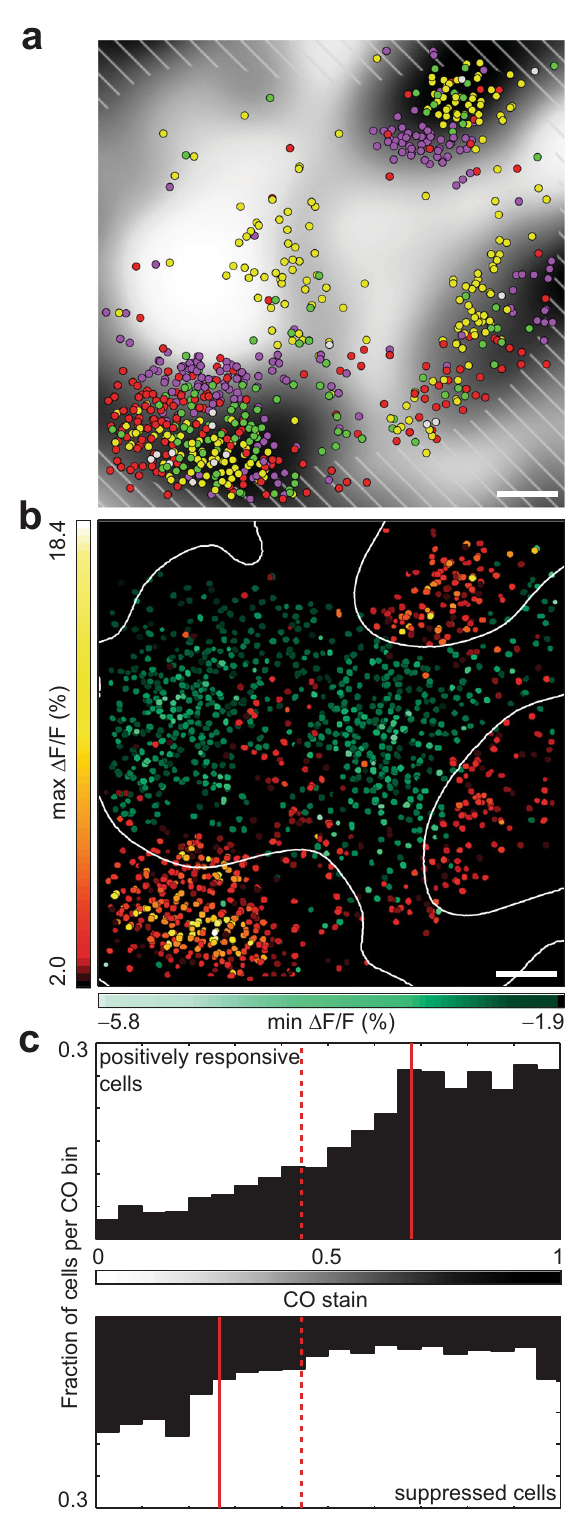
grayscale, histogram-equalized blob map). The resulting distribu- tion of CO values showed a pronounced tendency for positively responsive cells to reside in areas of darker cytochrome staining (Fig. 3c, upper panel; n = 3365; median CO = 0.68, IQR = 0.46 – 0.82), and the difference in median CO between positively responsive cells and the entire population of segmented cells ( n =